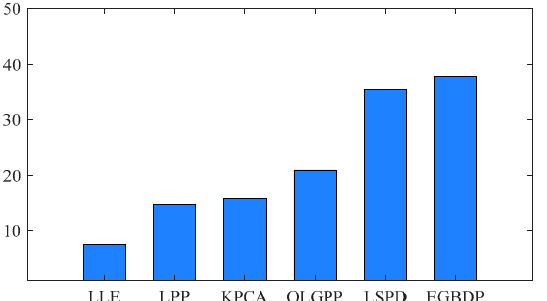
Figure 14. Low-dimensional feature separability index based on different algorithms.